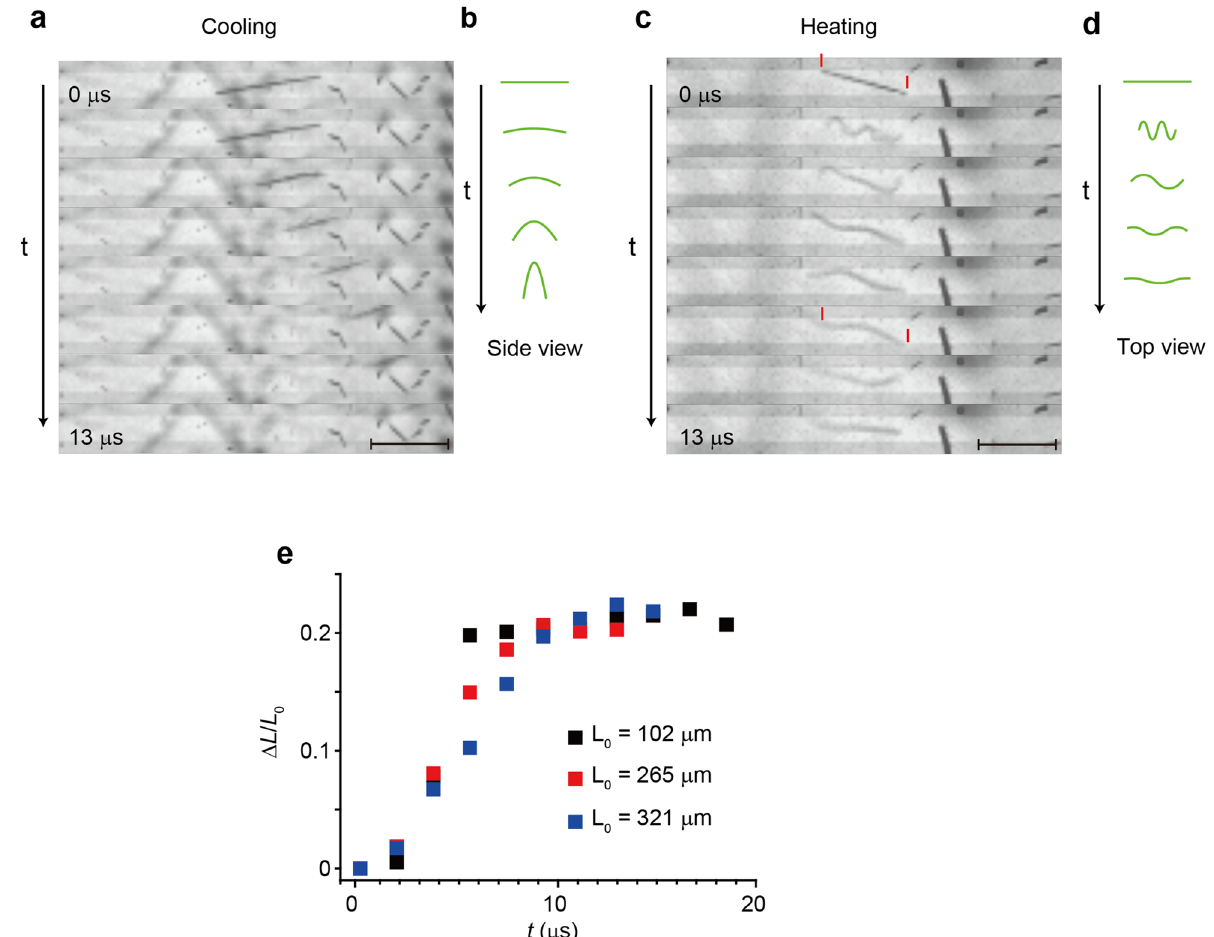
Figure 3. Jumping nanofibers recorded with high-speed camera operated at 5.4 × 10 5 fps. (a )